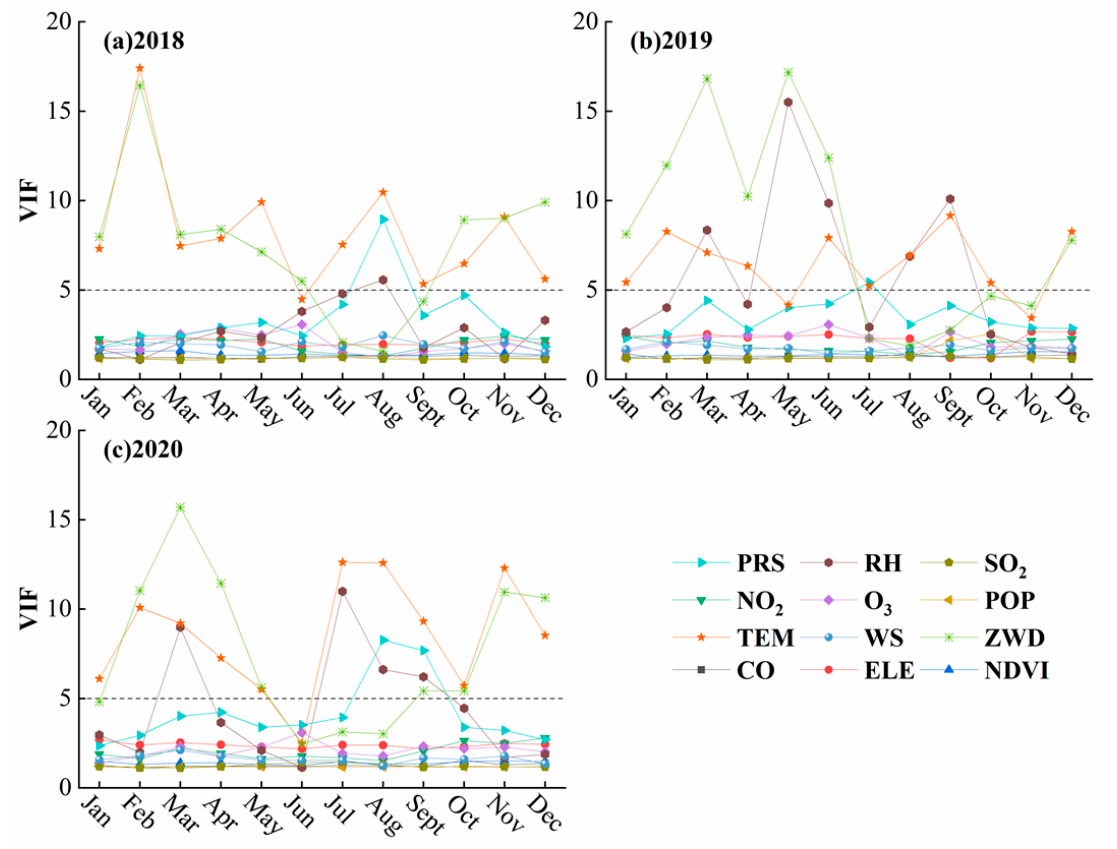
Figure 5. Results of multicollinearity diagnostics for each month of ( a ) 2018, ( b ) 2019, and ( c ) 2020, with points of different shapes and colors indicating the VIF values between the corresponding explanatory variables and the remaining explanatory variables.